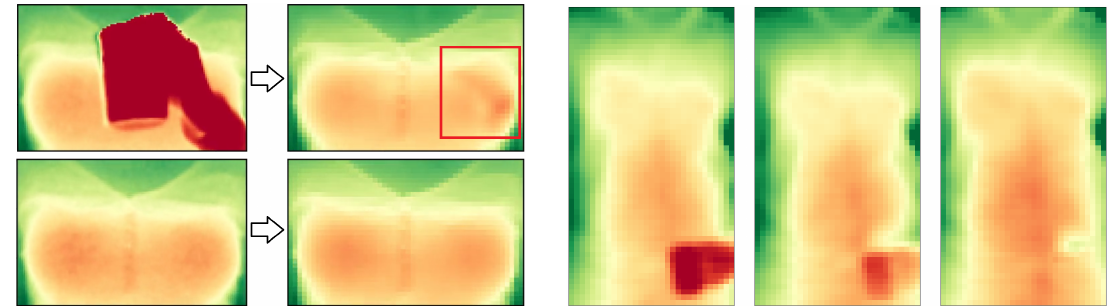
Figure 13. Left : Comparison of occlusion vs no occlusion on the prediction. Note the difference in the highlighted area. Right : Example of the adaptiveness of the model: An initial occlusion fades away as soon as the occluded area gets